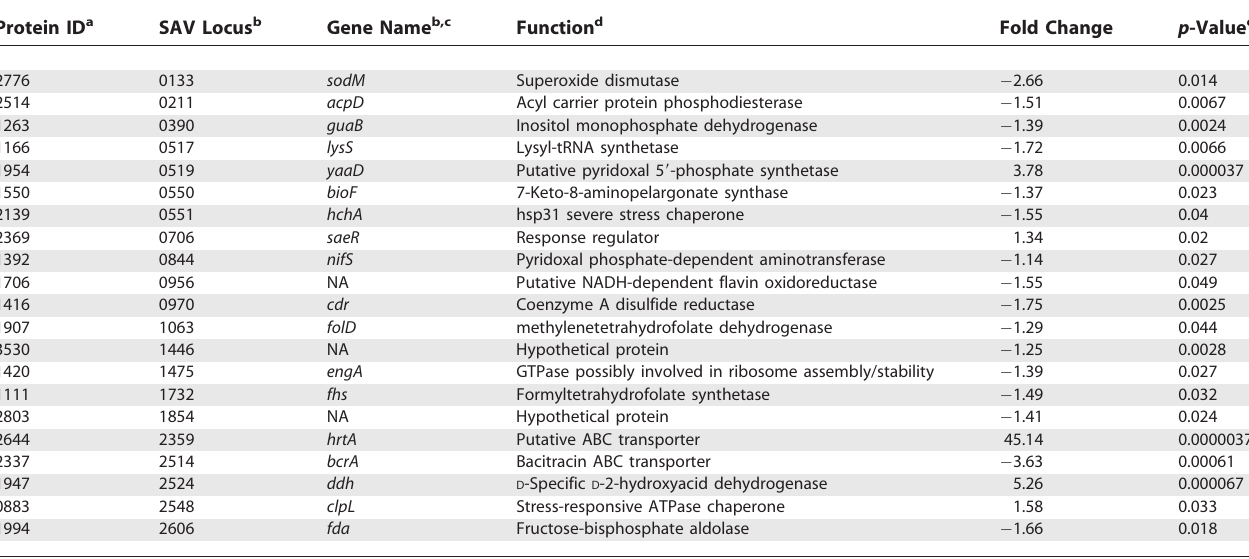
Table 1. Proteins Affected by Hemin Independent of Iron and Fur Protein ID a SAV Locus